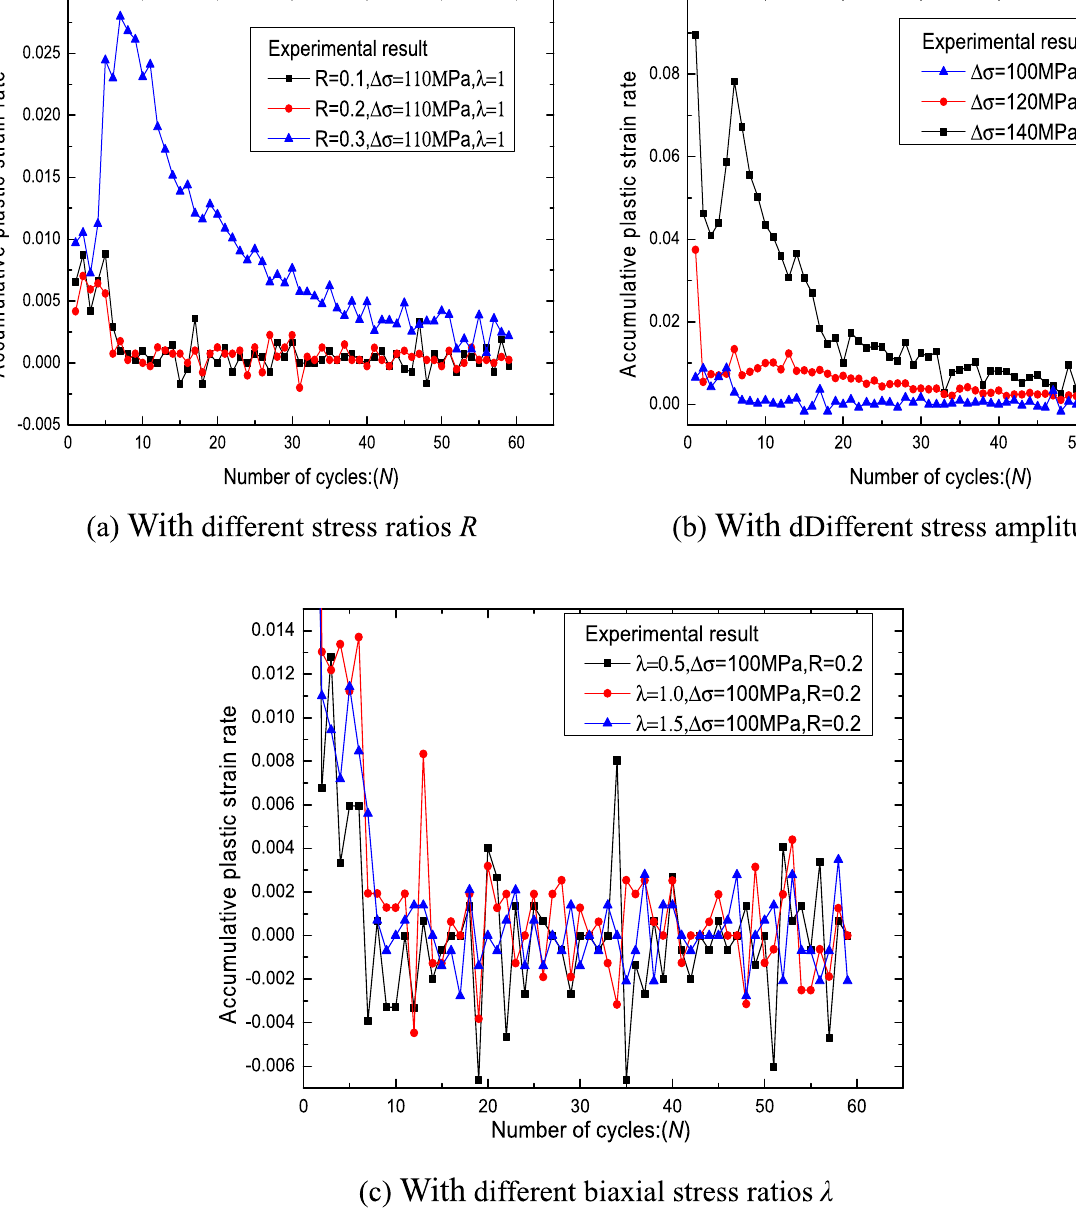
Figure 12 systematically analyzes the variation